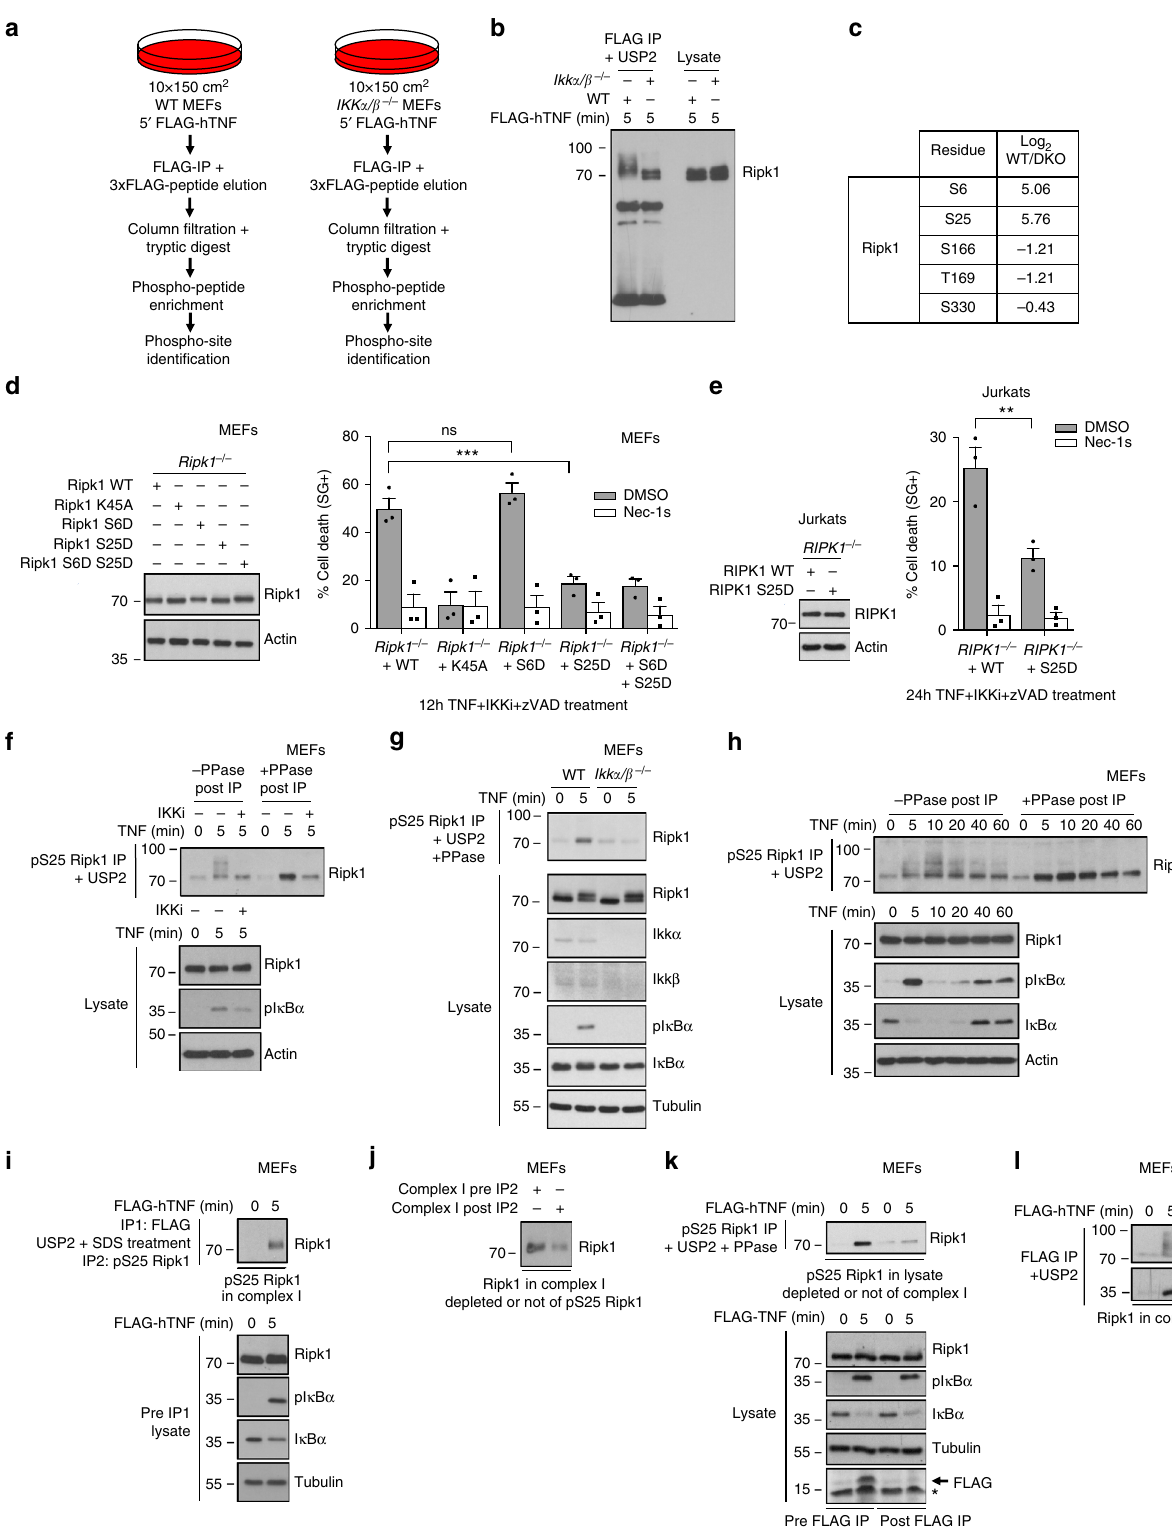
successively immunoprecipitating complex I and then pS25 RIPK1 from complex I (Fig. 1i). The analysis of the abundance of RIPK1 in complex I prior and after pS25 RIPK1 depletion also indicated that most of the RIPK1 associated with complex I is phosphorylated on Ser25 (Fig. 1j). In contrast, Ser25